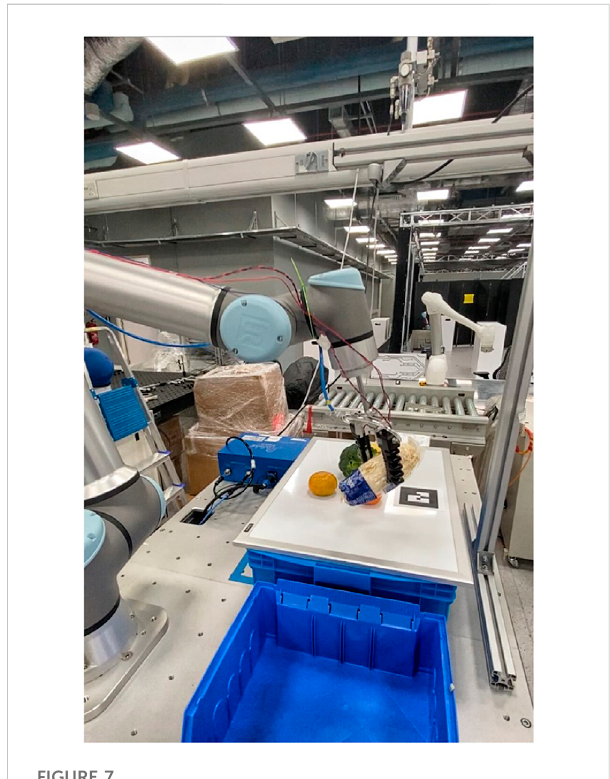
FIGURE 7 Data-driven soft gripping on the novel